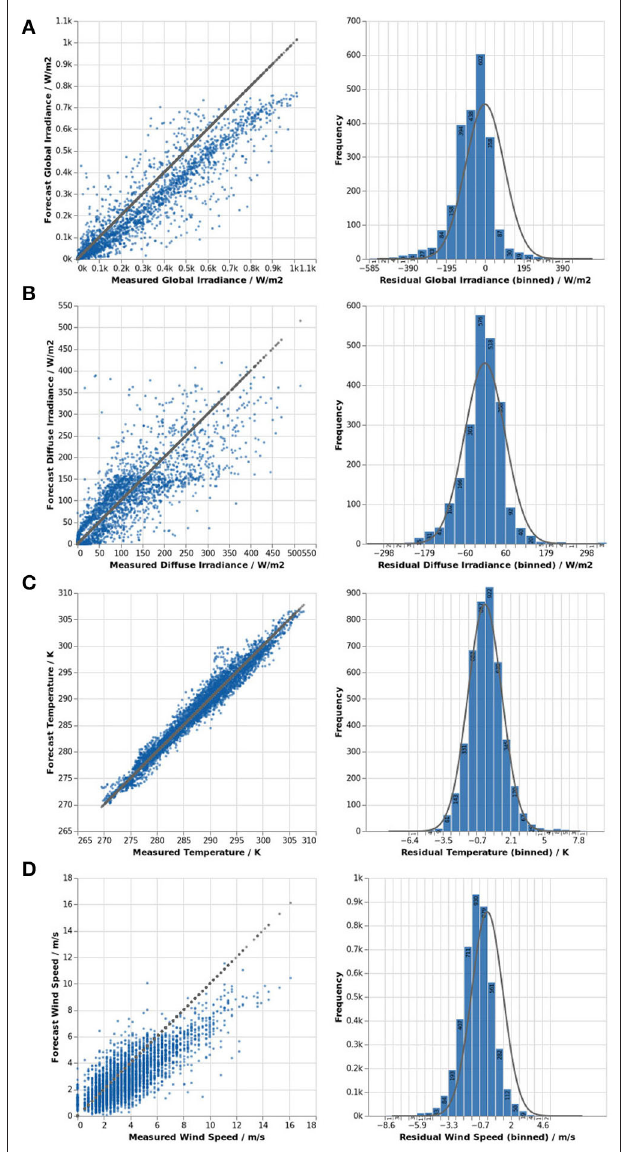
FIGURE 4 | Forecast quality of the COSMO-D2 weather forecast at DWD station 10704 from 2018-06-21 – 2018-12-21: global horizontal irradiance (A) , diffuse horizontal irradiance (B) , air temperature, (C) and wind speed (D) .